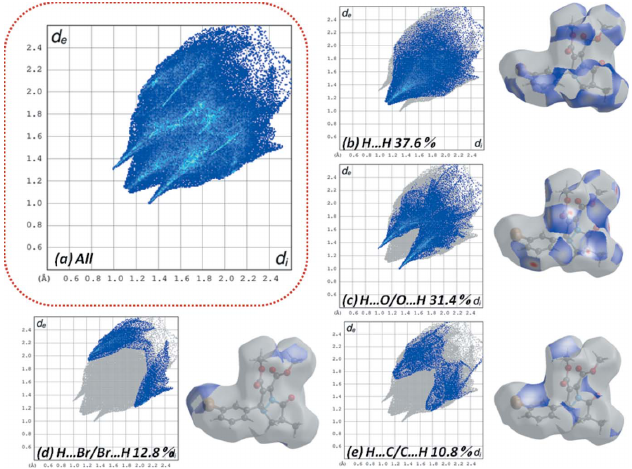
Figure 4 Two-dimensional fingerprint plots for the title compound showing ( a ) all interactions, and delineated into ( b ) H (cid:3)(cid:3)(cid:3) H, ( c ) H (cid:3)(cid:3)(cid:3) O/O (cid:3)(cid:3)(cid:3) H, ( d ) H (cid:3)(cid:3)(cid:3) Br/Br (cid:3)(cid:3)(cid:3) H and ( e ) H (cid:3)(cid:3)(cid:3) C/C (cid:3)(cid:3)(cid:3) H interactions.